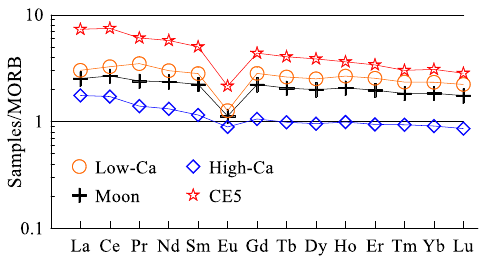
Figure 4. REE patterns of moon samples normalized to the MORB. Abundances of the MORB are from White and Klein [14].